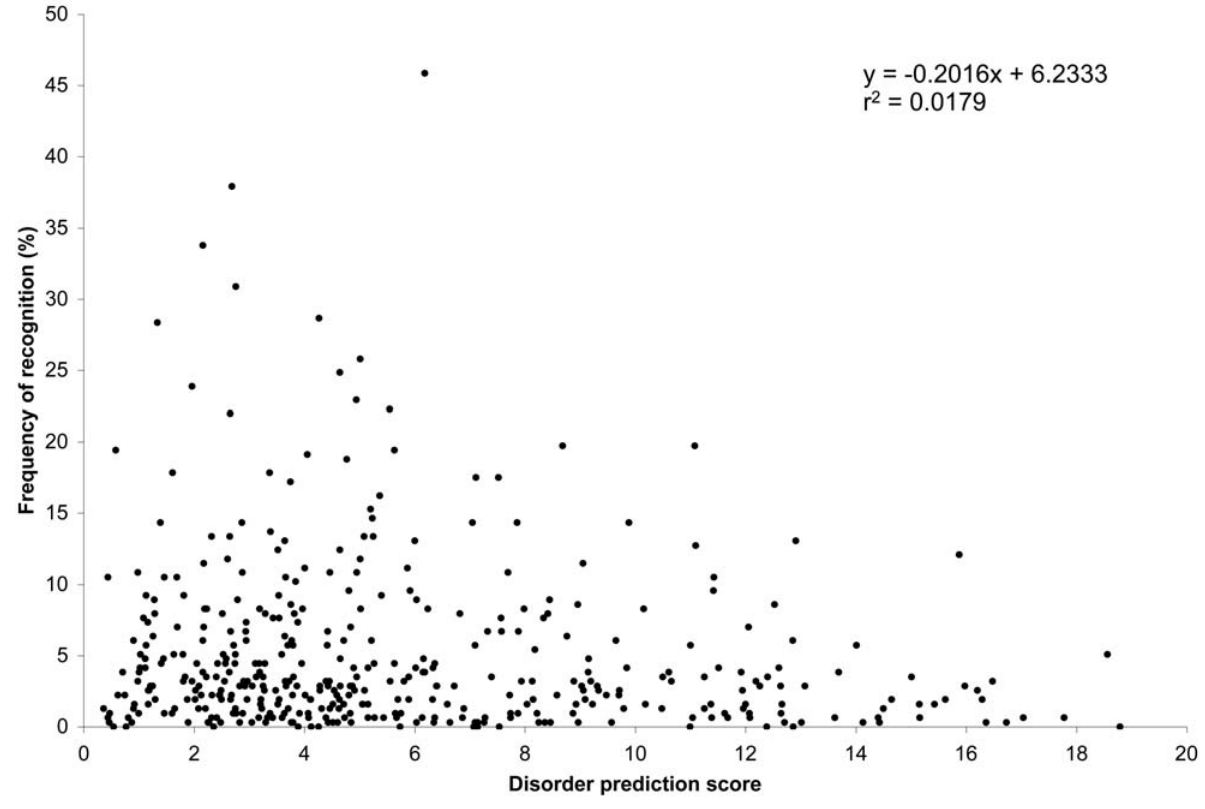
Figure 3. Frequency of recognition of HIV-1 B consensus 2001 peptides as a function of their intrinsic disorder prediction score. The vertical axis corresponds to the percentage of HIV-1 infected individuals that recognized each of the 410 peptides spanning the HIV-1 B consensus 2001 proteome. The horizontal axis corresponds to the disorder prediction score for each peptide, calculated using predictions of order/disorder made with the VSL1 predictor (PONDR H ).